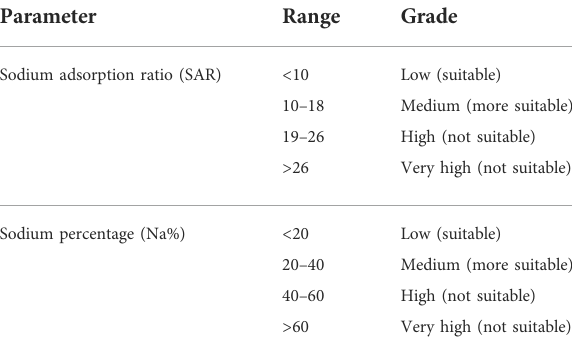
TABLE 1 The classi fi cation statistics of SAR and Na% irrigation suitability. Parameter